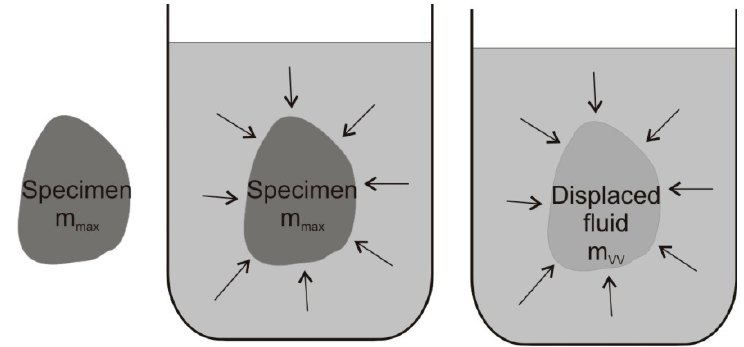
Figure 1. Scheme of the specimen and displaced fluid assumed in Archimedes’ principle (arrows show the same applied pressure of the adjacent fluid on specimen mass m max and displaced fluid mass m vv ).